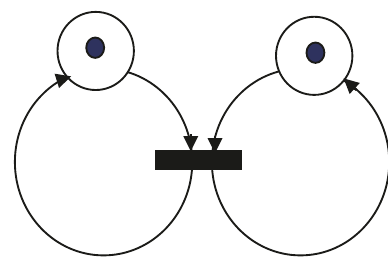
Figure 8: Structures leading to a death of a mark.